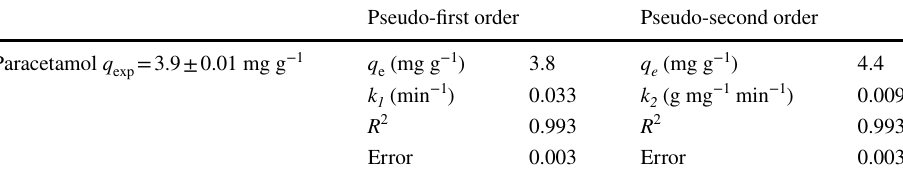
Table 1 Kinetic parameters of the pseudo-first and pseudo- second order models and for adsorption of PAR